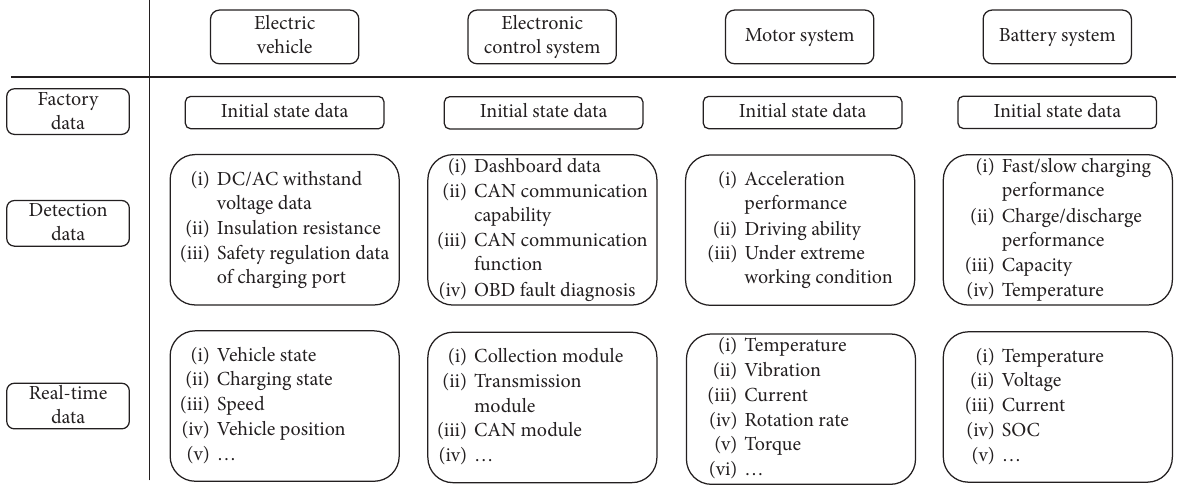
Figure 2: Composition of health management